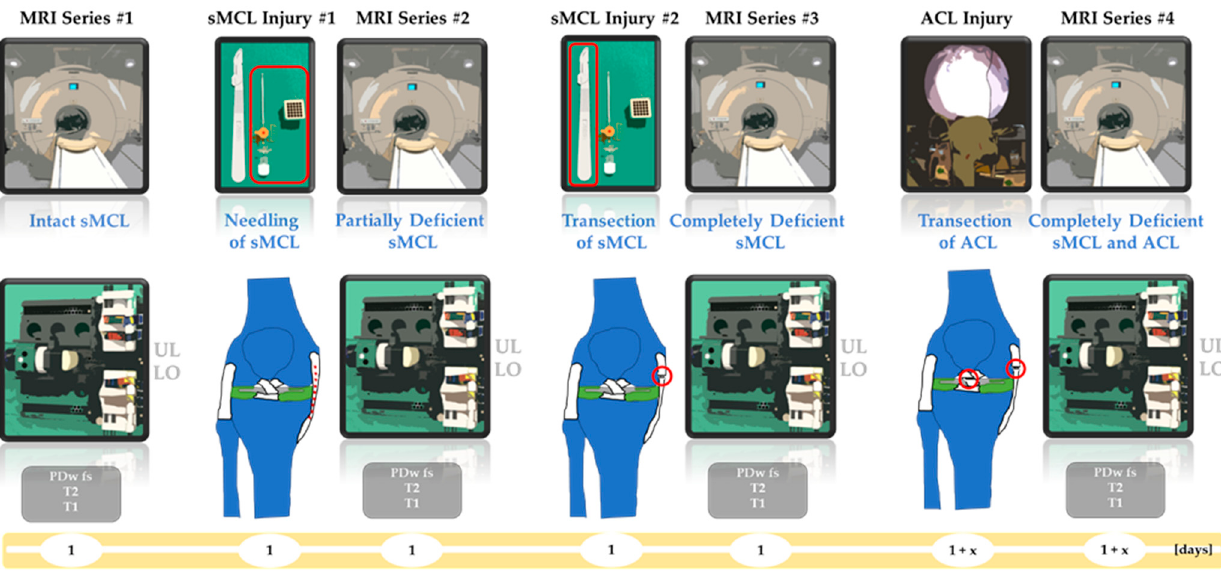
Figure 3. Timeline of MRI series and graded injuries. Sequentially, the superficial medial collateral ligament (sMCL) was partially injured, i.e., needled (sMCL injury #1), and completely injured, i.e., transected (sMCL injury #2). The anterior cruciate ligament (ACL) was transected (ACL injury). Consequently, the knee joints were imaged in the sMCL-intact condition (MRI series #1), partially sMCL-deficient condition (MRI series #2), completely sMCL-deficient condition (MRI series #3), and the combined sMCL- and ACL-deficient condition (MRI series #4). MRI series refer to the imaging protocol (grey boxes) that was completed for each joint in the unloaded (UL) and loaded (LO) configurations. Unit of timeline is days (yellow).